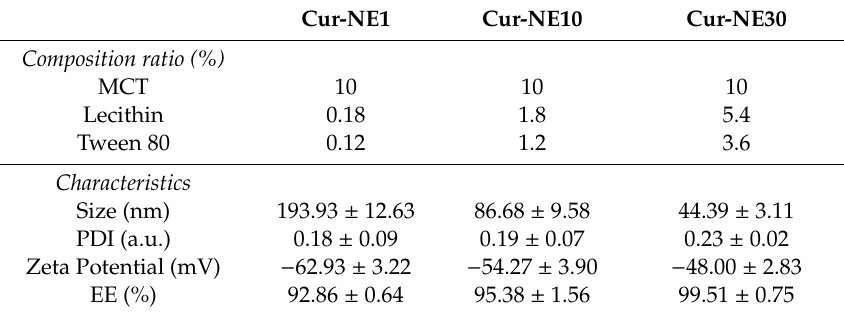
Results are presented as mean ± SD ( n = 3). MCT, medium chain triglyceride. PDI, polydispersity index. EE, entrapment e ffi